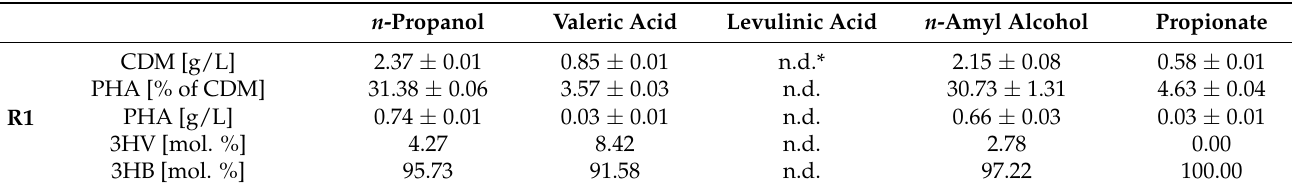
Table 4. Ability to produce copolymers containing 3HV from different types of precursors, R1— R. xylanophilus, R2— R. spartanus (72 h, 45 ◦ C, 180 rpm) . n -Propanol Valeric Acid Levulinic Acid n -Amyl Alcohol Propionate CDM [g/L] PHA [% of CDM] PHA [g/L] R1 3HV [mol. %] 3HB [mol. %]